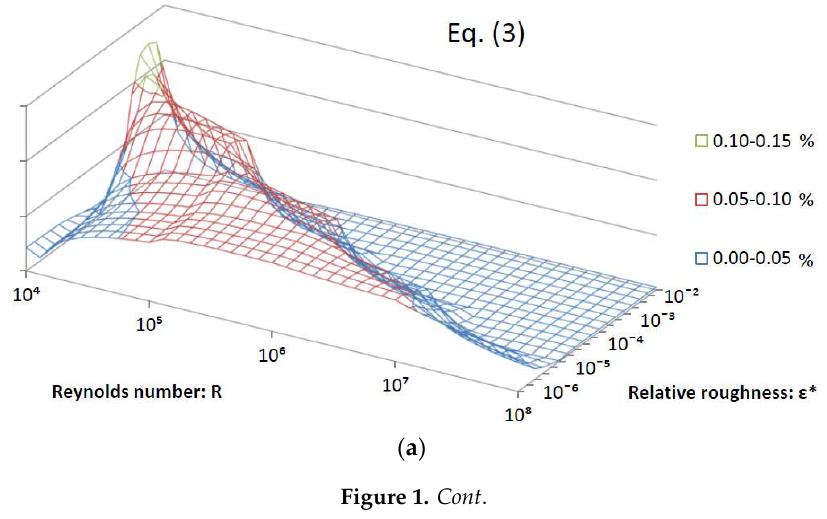
Mathematics 2018 , 6 , x